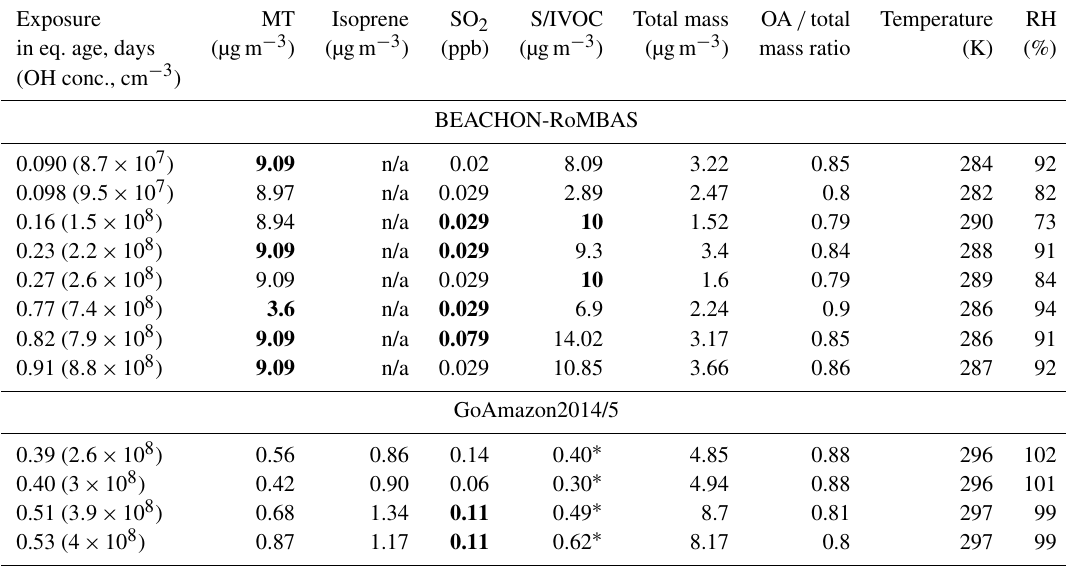
Table 2. All BEACHON-RoMBAS and GoAmazon2014/5 model inputs (assumed values for missing data points in bold). Each value represents the ambient condition present at the beginning of each modeled exposure. The OH concentration is calculated by assuming that 1 day of aging is equal to a 24h average atmospheric OH concentration of 1 . 5 × 10 6 molecdaycm − 3 and that the average residence time of the OFR was 134s at BEACHON-RoMBAS and 171s at GoAmazon2014/5. Isoprene was not a model input for the BEACHON-RoMBAS cases and so their values are non-applicable